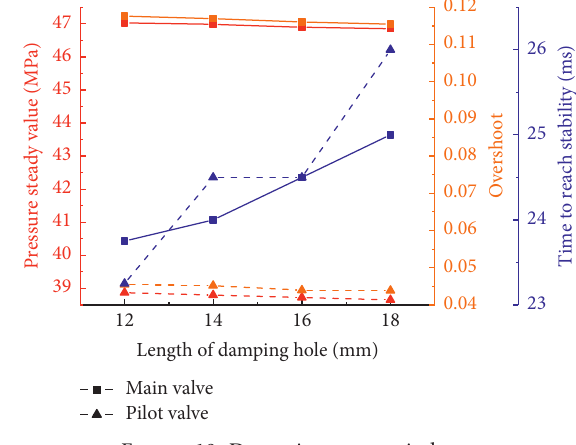
Figure 19: Dynamic response indexes. Table 3: Optimized structural parameters of relief